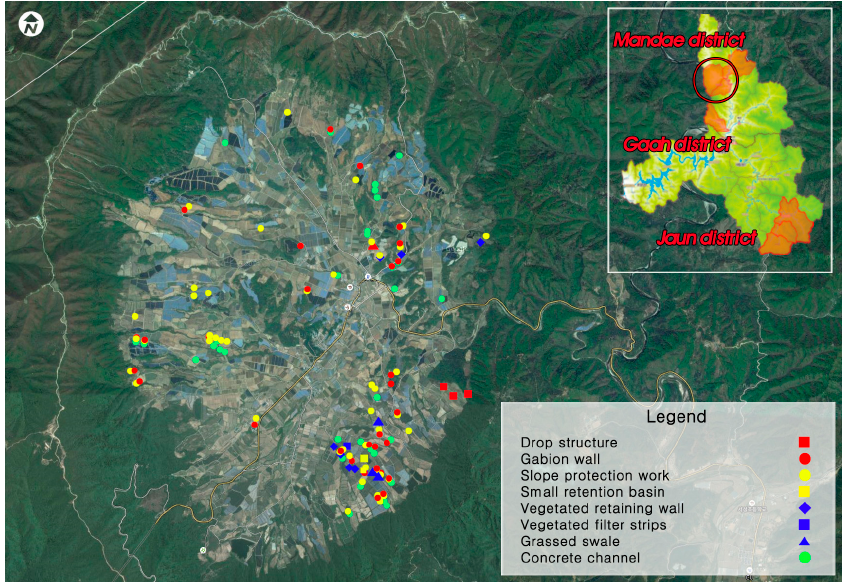
Figure 2. Map of the BMPs in the Madae area of Yanggu-gun.